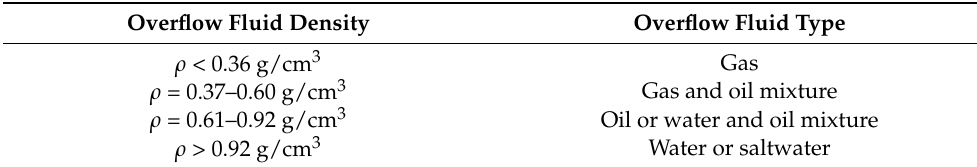
Table 1. Criteria for the type of overflow